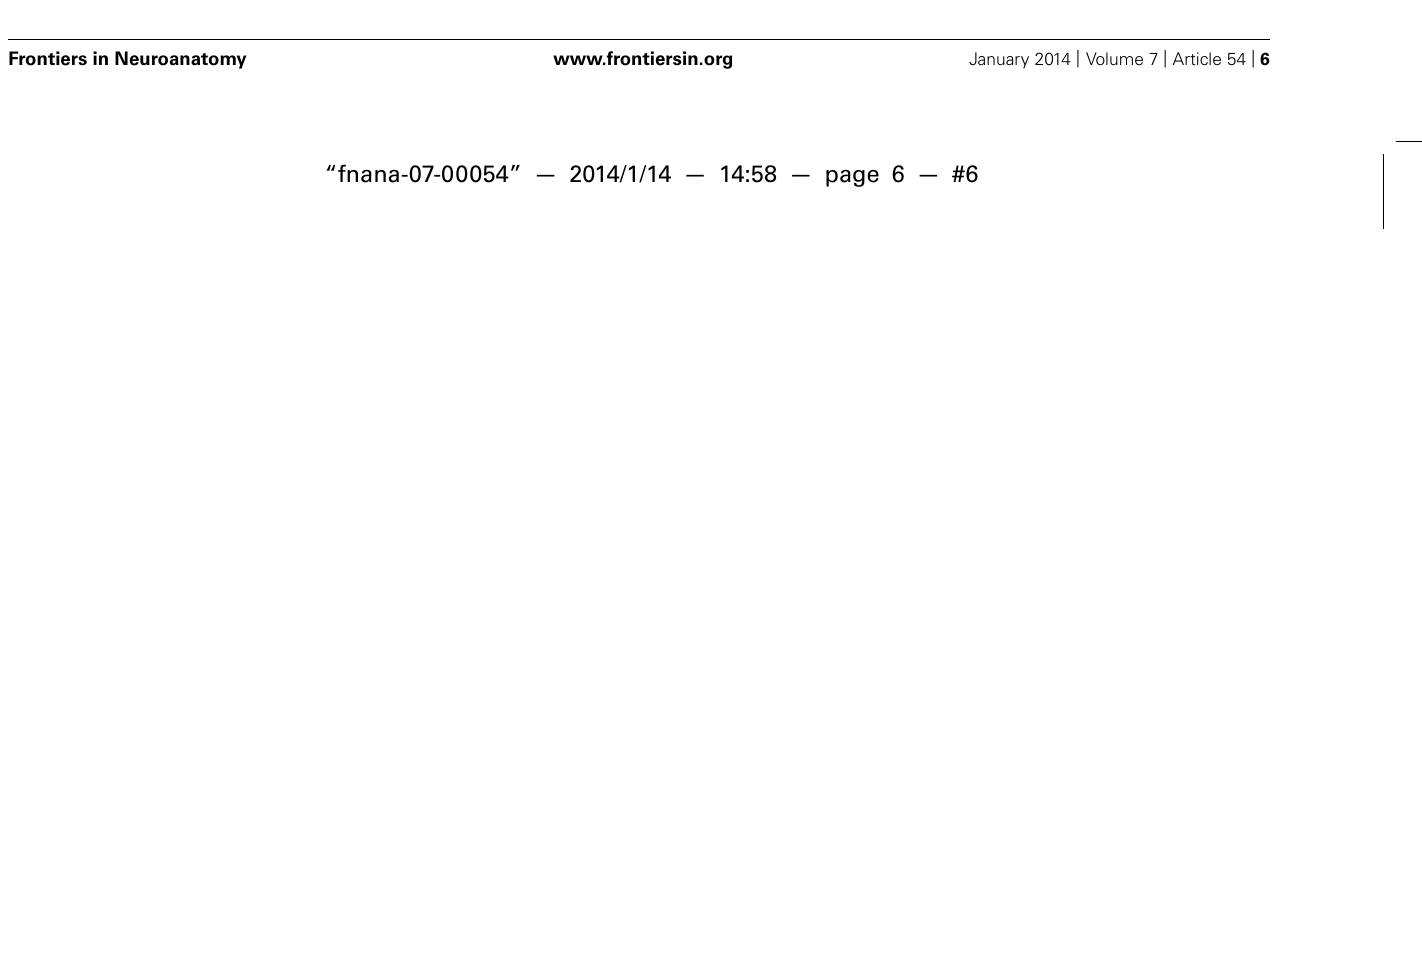
stain DAPI (blue) in the human, E14.0 and E16.0 rat pallium, and striatum. (C,F,I,L,O) Expression of SATB2 (red) and PAX6 (green) in the human, E14.0 and E16.0 rat pallium, and cortical subplate. Abbreviations see Figure 1 . Scale bars: 500 μ m in A–C,G–I ; 200 μ m in D–F ; 10 μ m in J–O